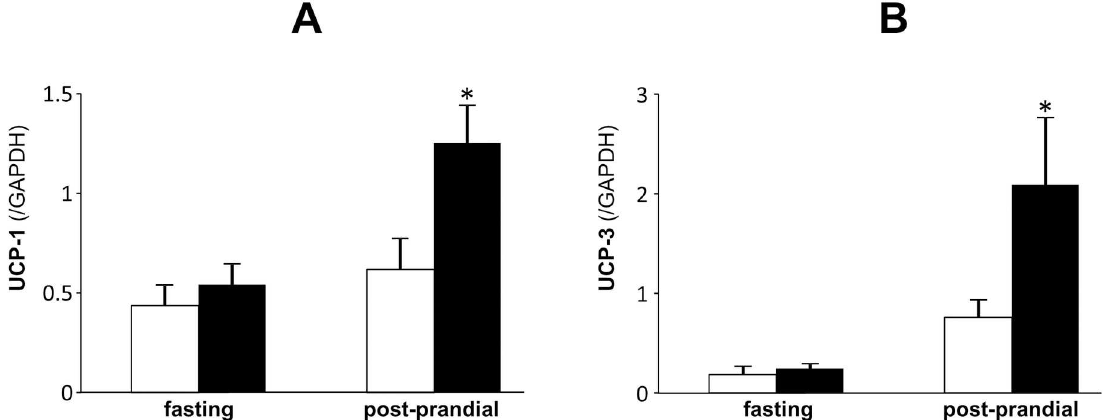
Fig 7. Adaptive thermogenesis-relatedgene expressions in the brown adipose tissue and skeletal muscle of SD rats at 15 weeks old. A; UCP1 , B; UCP3 expressioncorrected by Gapdh expression. Open bars denote control group and black bars denote metformin-treatedgroup. Data are presented as mean ± S.E. (n = 6 in each group). * P < 0.05vs. control groups.